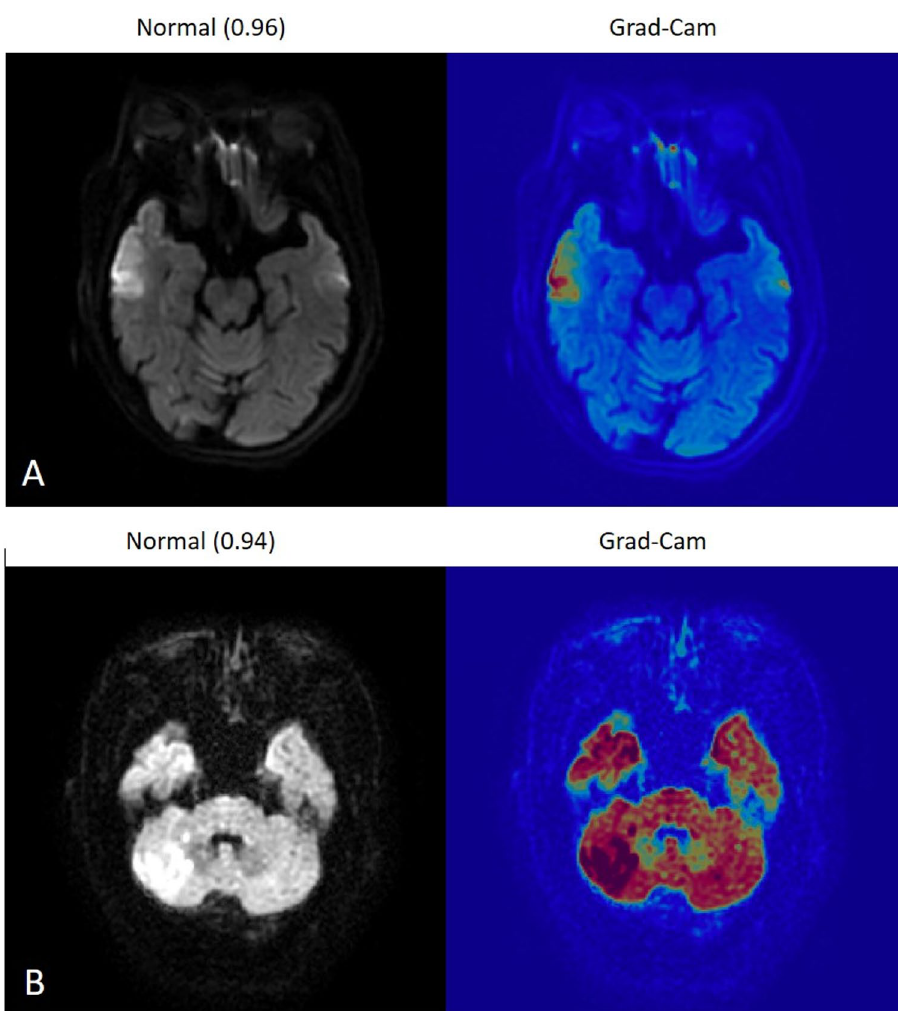
Figure 3. Example images of misclassification, the first case was right temporal lobe infarction, but miss- classified into normal by EfficientNet-b0 model ( A ), and second case was right cerebellar infarction but miss- classified into normal by the modified LeNet model ( B ). The number in bracket represent classification